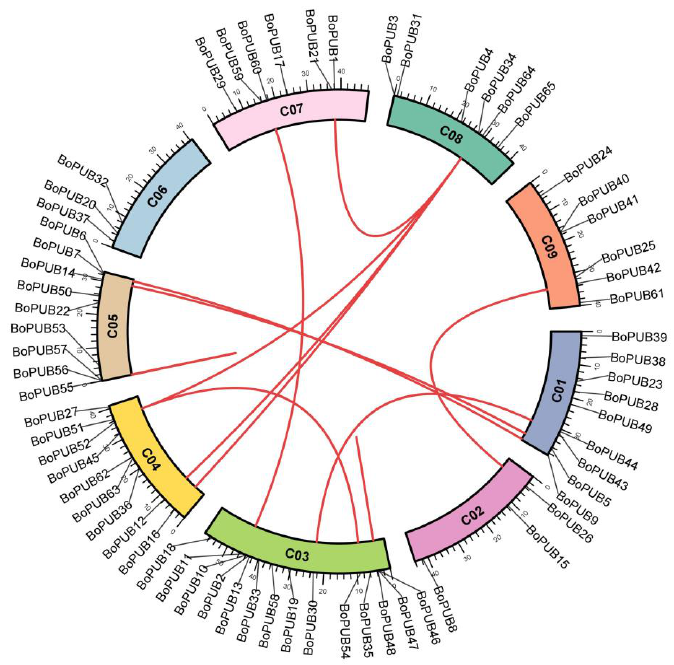
Figure 3. Distribution and duplication of BoPUB genes. Nine chromosomes (C01–09) in cabbage are arranged in a circular pattern, and the location of 65 BoPUB genes is marked. Red lines represent the homologous relationships of BoPUB genes.